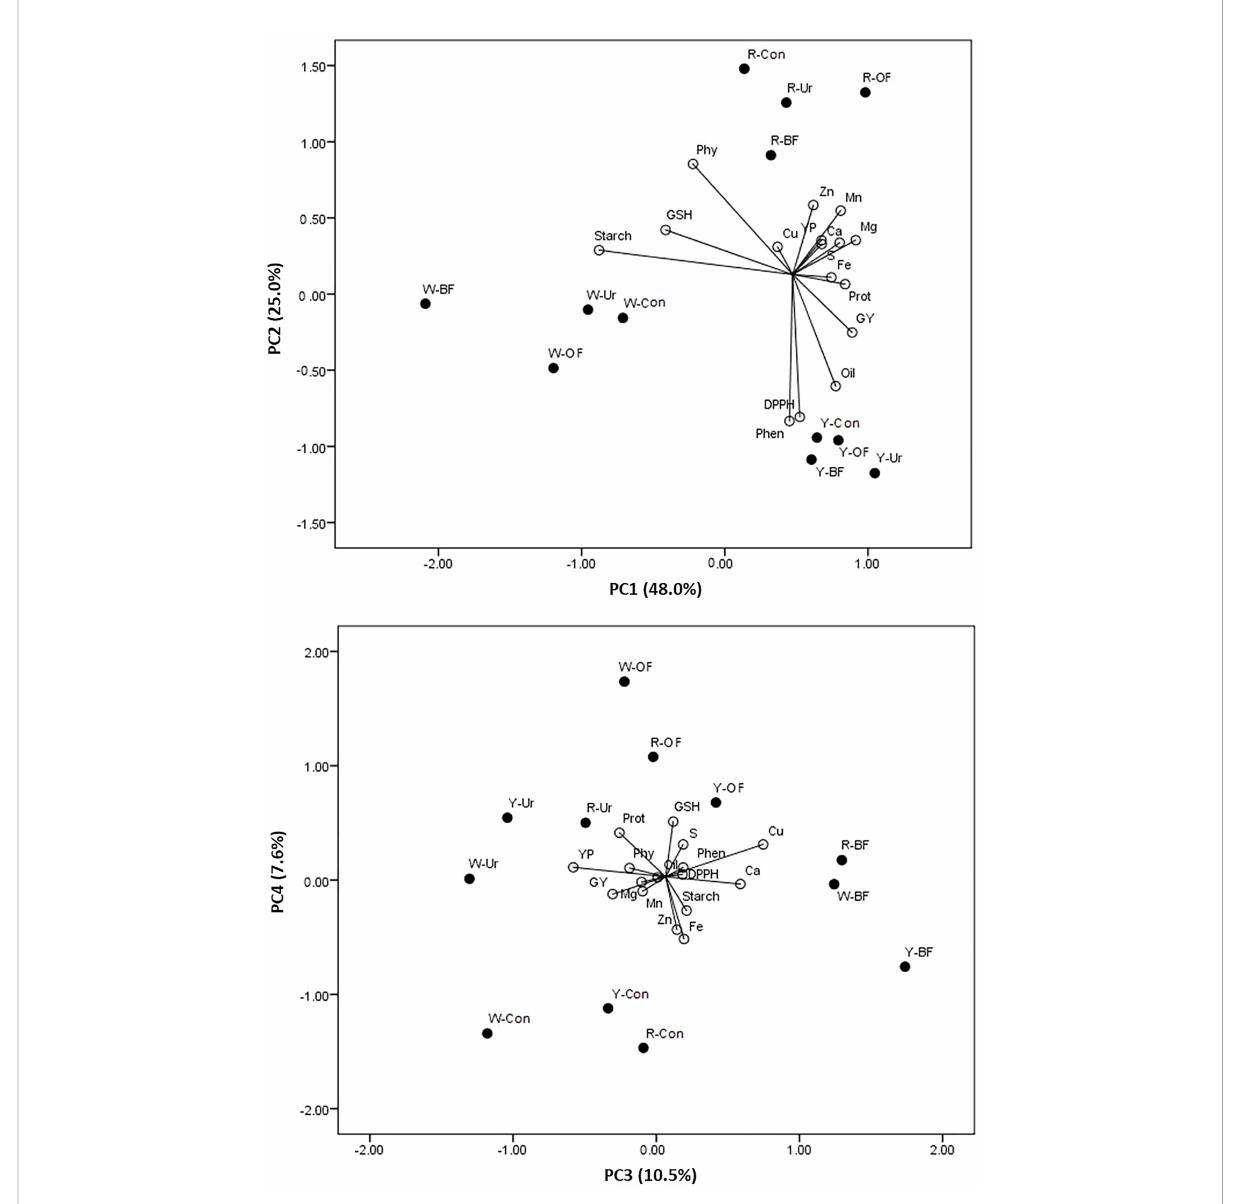
FIGURE 1 Principal component analysis of the grain yield (GY), protein (Prot), oil, starch, phytic phosphorus (Phy), phenolics (Phen), yellow pigment (YP), and glutathione (GSH) contents, reduction capacity of the DPPH radical (DPPH), and concentrations of Mg, Ca, Fe, Mn, Zn, Cu, and S in maize with different kernel colors (W, white; Y, yellow; R, red), under different fertilizer treatments(BF, biofertilizer; OF, organic fertilizer; Ur, urea; Con,